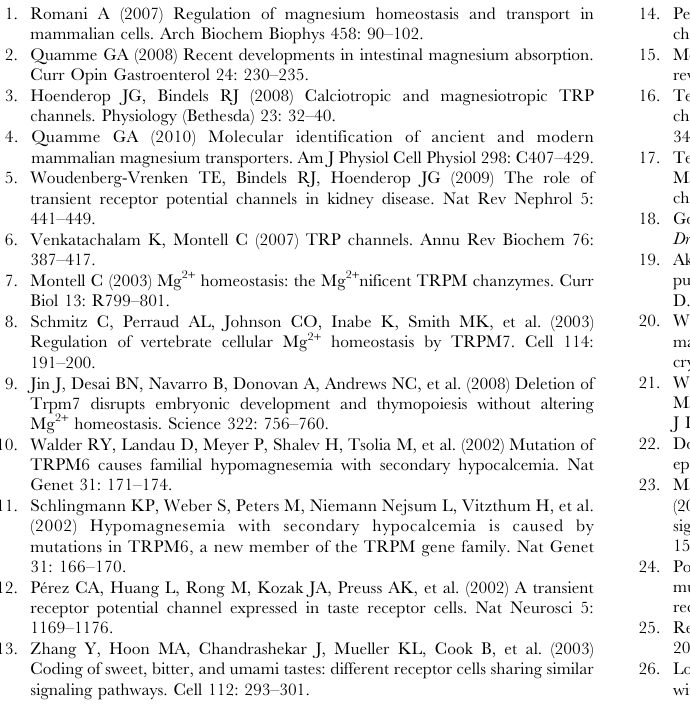
Figure S1 Cloning of trpm cDNAs and developmental expres- sion of the trpm mRNA. (A) Cladogram including TRPM proteins in humans, worms and several insects. The relationships were based on the amino acid sequences encompassing the pore and S6 domains and calculated using the ClustalW algorithm. (B) encoded protein isoforms in amino acids (aa) are indicated. (C)